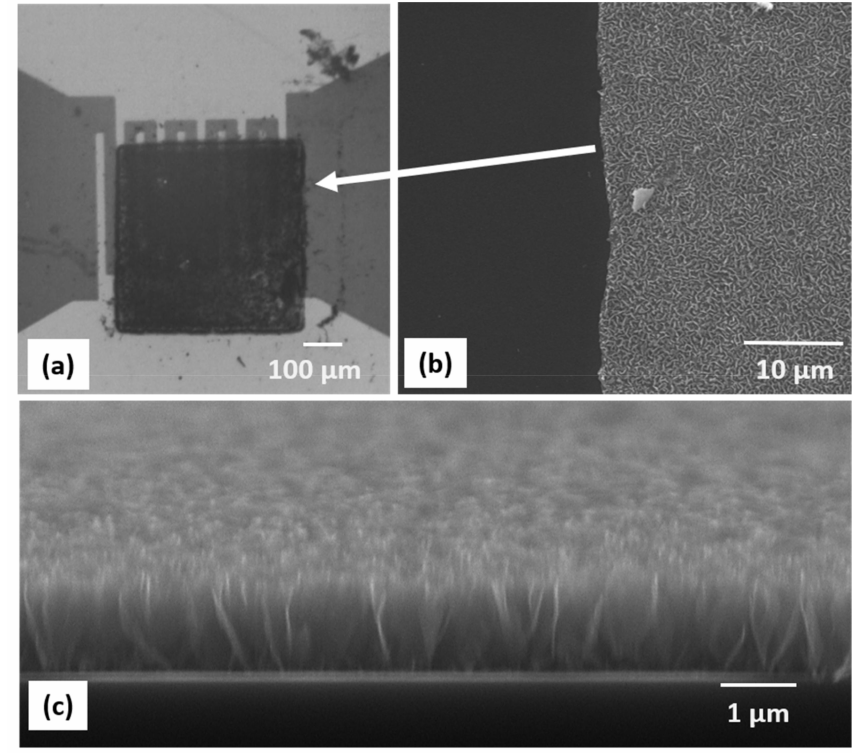
Figure 5. ( a ) Optical microscopy image of a CNW pixel printed onto the IDTs of a chemiresistive sensor. ( b ) Top-view SEM image taken at the edge of the CNW pixel, where a clean-cut, sharp edge can be noticed. ( c ) Cross-section SEM image of a CNW pixel (the pixel thickness is 1 µ